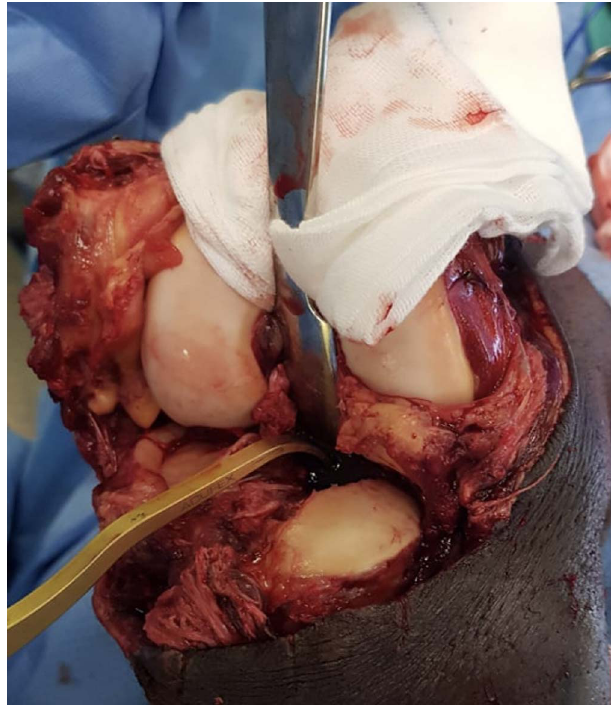
Figure 2. Open surgery in a patient with a traumatic knee arthrotomy and MLKI. Open cruciate surgery done in a patient with an open knee dislocation, patella tendon rupture and large traumatic arthrotomy. The PCL tunnel is drilled under direct vision with a PCL tunnel